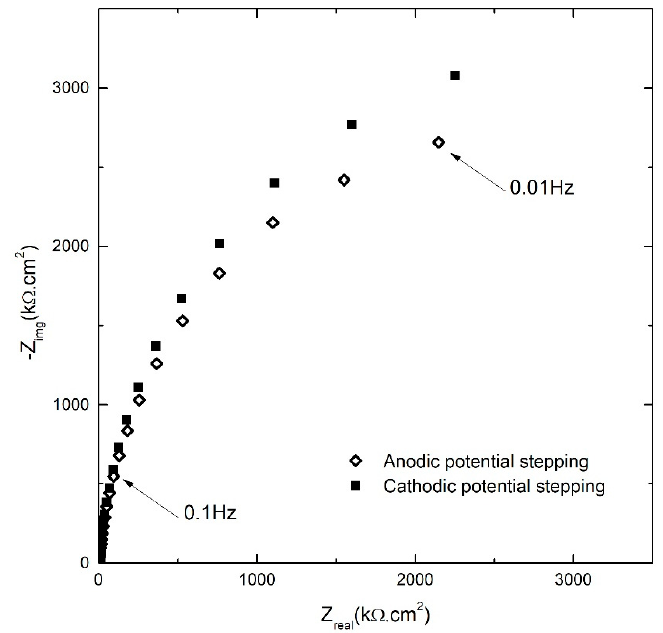
Figure 3. Nyquist plots of the AA2098 – T851 alloy in 0.1 M NaHCO 3 /1 atm of CO 2 at 25 °C for both anodic and cathodic potential stepping directions at +300 mV SCE [31].